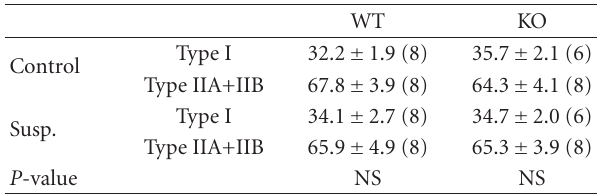
Table 2: Soleus fiber types based on MHC/SDS-PAGE